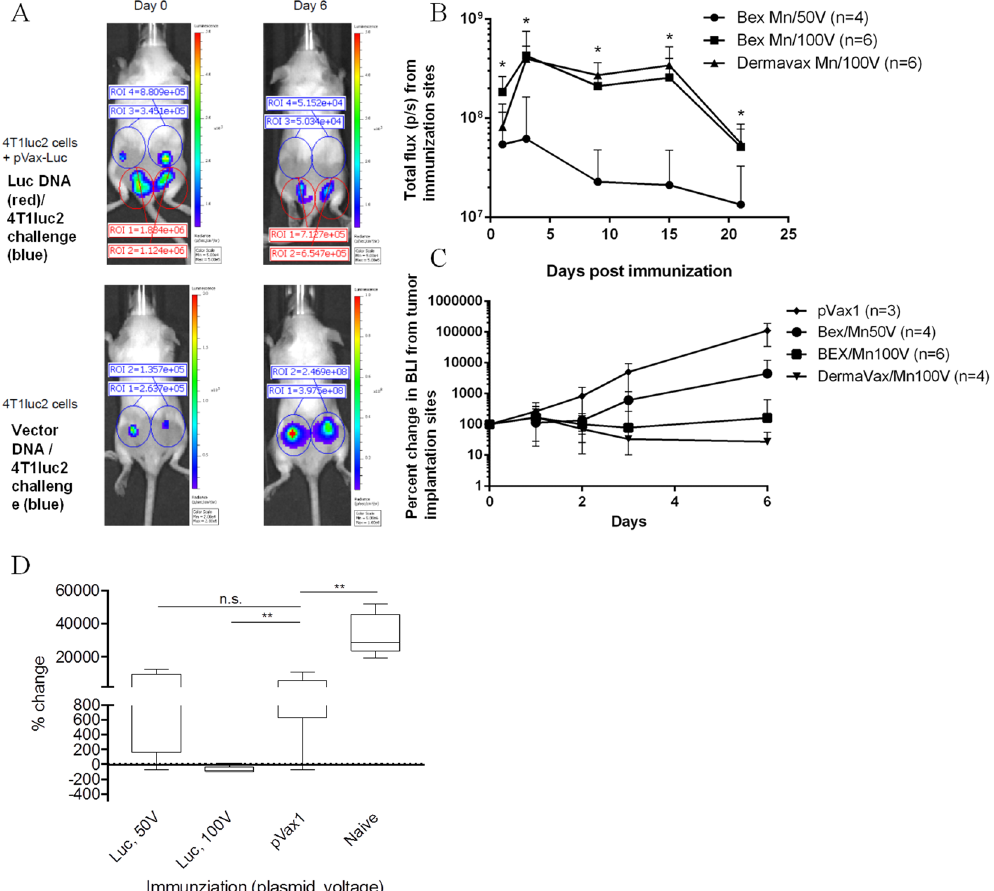
Figure 8. Intradermal Luc DNA immunization followed by electroporation (EP) with driving pulses of 100 V makes BALB/c mice resistant to initiation of 4T1luc2 tumors. BALB/c mice were immunized by plasmid encoding firefly luciferase pVaxLuc delivered by intradermal injections followed by EP using multineedle (Mn) electrodes mounted on Dermavax (Cellectis) (n = 4) or CUY21EditII (BEX Ltd) electroporators at 100 V (n = 6) or 50 V (n = 4). Immunization (red circles) and 4T1luc2 implantation sites (blue circles) visualized by in vivo imaging (Spectrum CT) on days 1 and 6 post tumor cell implantation (43 and 48 days of the immunization cycle). Mice immunized with Luc DNA (A, upper panel) versus empty vector (A, lower panel). Text boxes demonstrate total flux from the respective regions of interest (ROI) (photons/sec) ( A ); Quantification of bioluminescence emission (BLI; photon flux/sec) from immunization sites illustrates the efficacy of Luc gene transfer and expression. From day 5, Luc DNA immunized mice electroporated at 100 V emitted stronger bioluminescence than mice electroporated at 50 V (p < 0,05; Mann Whitney test), no bioluminescence from immunization sites in control mice receiving pVax1 ( B ); Quantification of bioluminescence (photon flux/sec) from 4T1luc2 implantation sites in mice immunized with Luc DNA and electroporated with DermaVax/Mn at 100 V (n = 4), BEX/Mn at 100 V (n = 6), BEX/Mn at 50 V (n = 4), and vector immunized mice (n = 3) on days 0 to 6 post challenge ( C ); Difference (in %) in BLI from 4T1luc2 implantation sites after six days of tumor growth in mice immunized with Luc DNA with EP at 100 V (DermaVax/Mn + BEX/Mn groups, 10 animals, dubbed “Luc, 100 V”), or 50 V (BEX/Mn, 4 animals, dubbed “Luc, 50 V”), vector immunized (n = 3) and naive mice (n = 5, from an independent experiment) ( D ). * p < 0,05; ** p < 0,1 (Statistica AXA